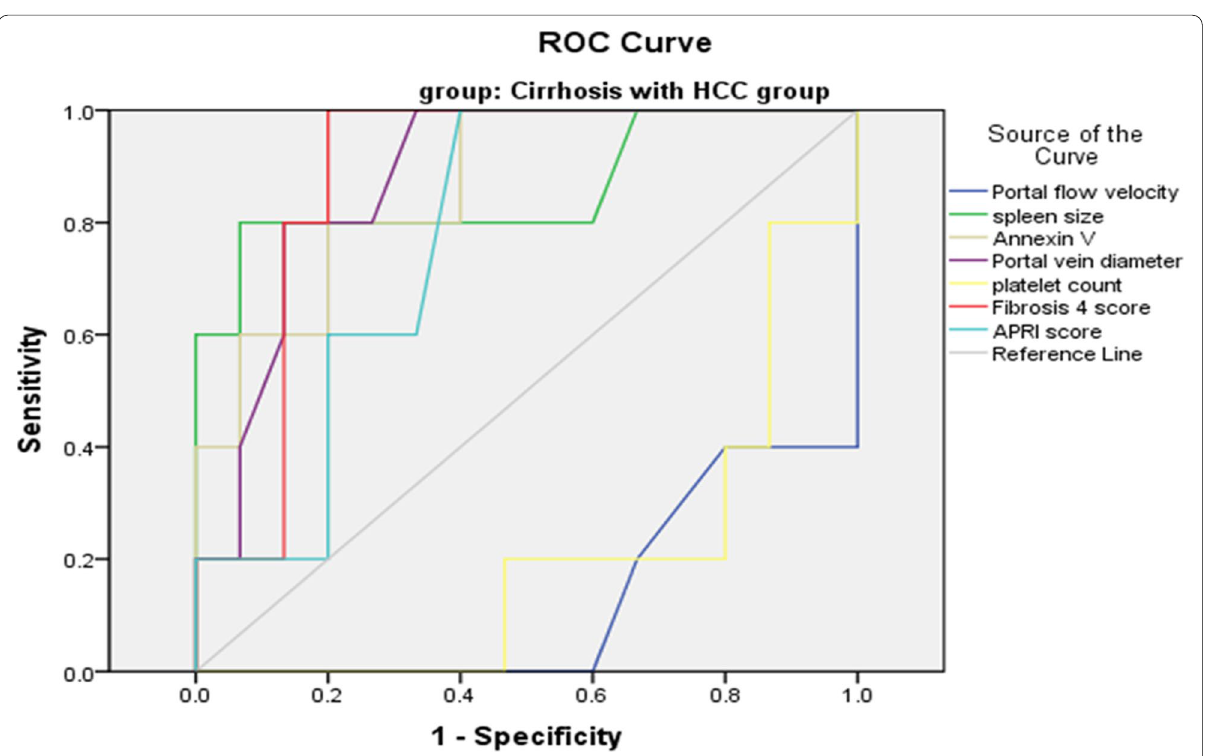
Fig. 3 ROC for the group of cirrhosis with